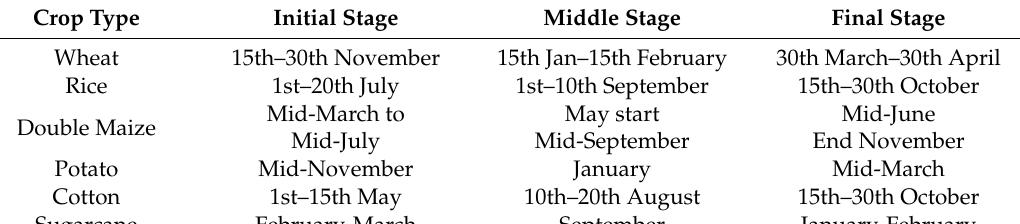
Table 3. Crop calendar of di ff erent crops in the Lower Bari Doab Canal (LBDC) region.